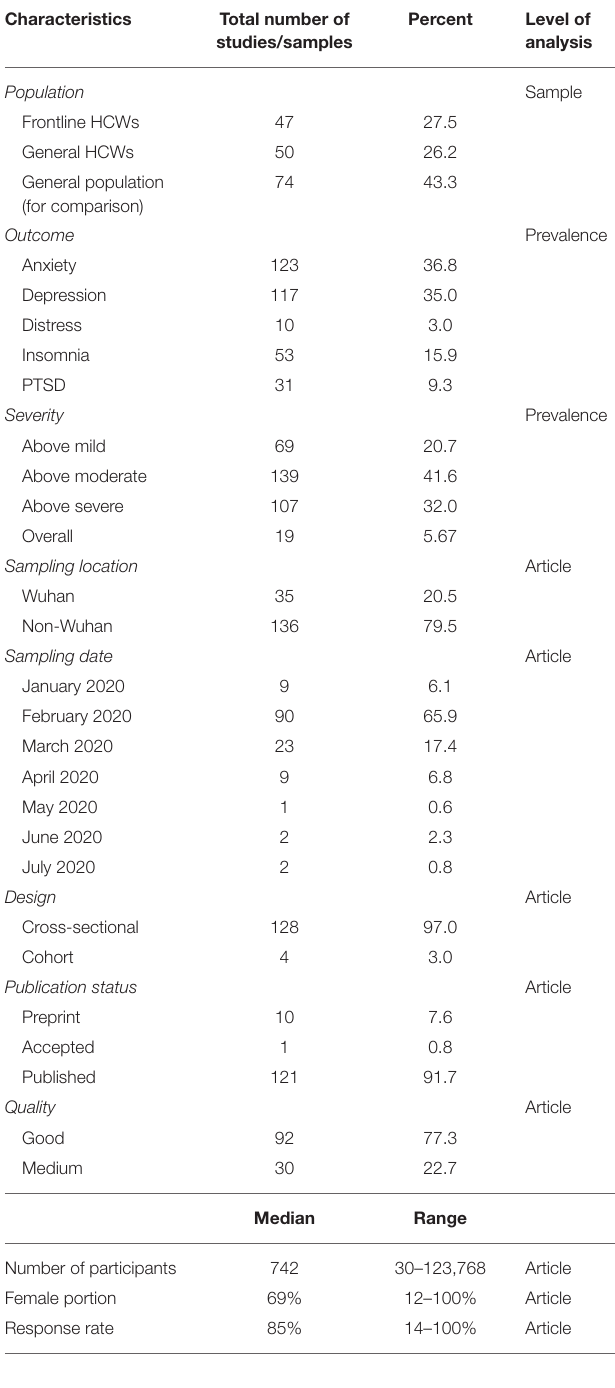
TABLE 1 | Characteristics of the studies on mental health in China in a year of COVID-19 epidemic.